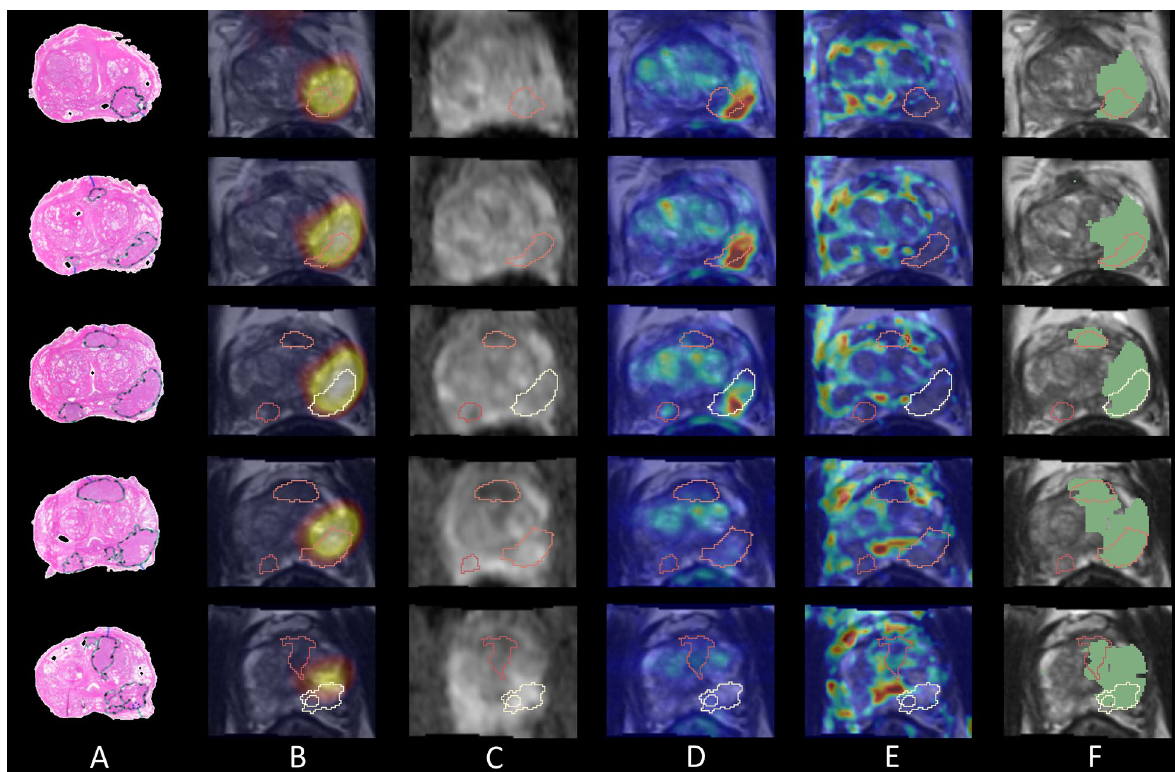
Fig. 6 Results from patient 64 showing image slices top to bottom (base to apex) with a tumour annotations on histology, b PET and T2w MRI, c the ADC map, d Ktrans map, e TTP map and f the predicted tumour voxels in green overlaid on the T2w MRI, each visualised with the tumour location outline from